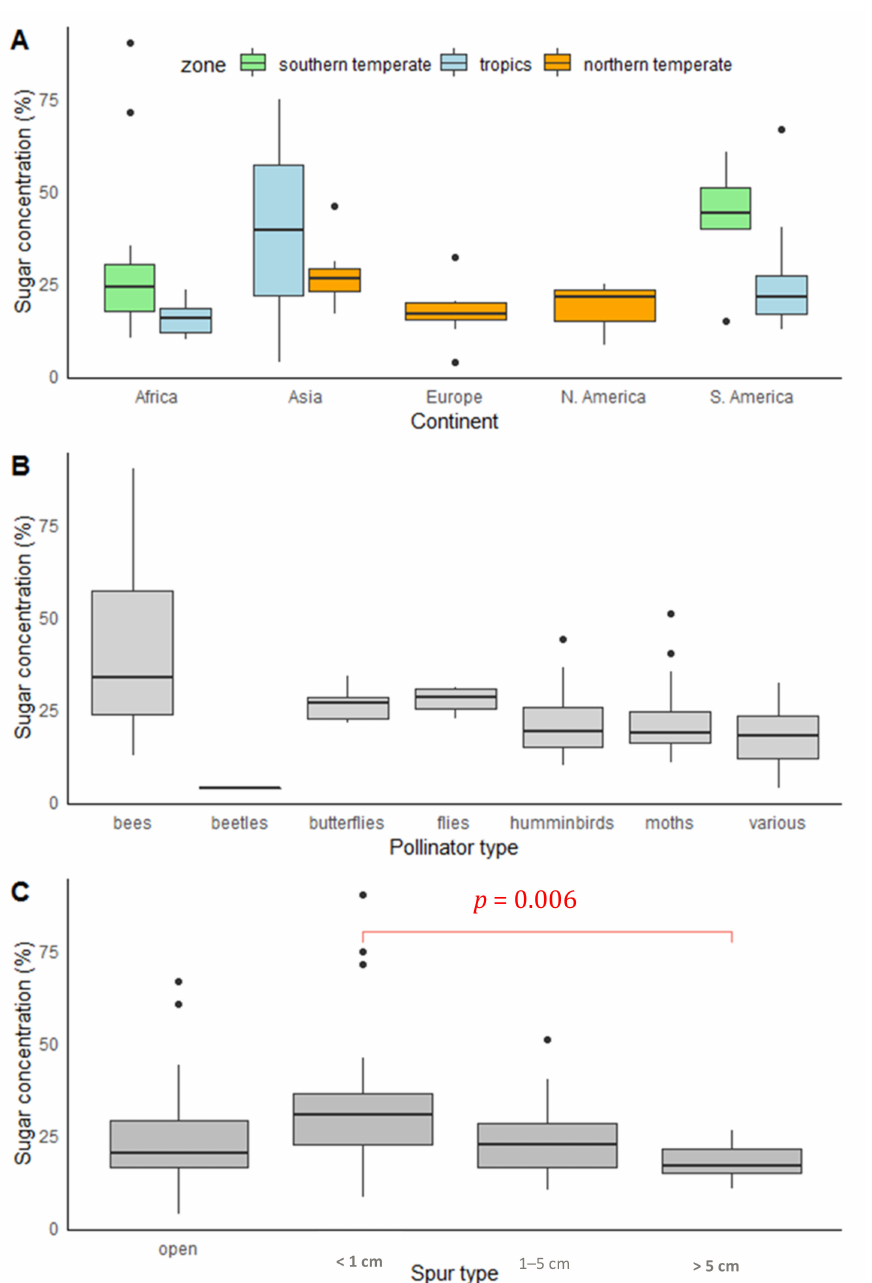
Figure 2. Sugar concentration in flowers of 106 orchid species around the globe depending on their geographical location ( A ), pollinator type ( B ), and spur type ( C ). Significant differences in Tukey’s post hoc test between spur length categories is indicated by a red line and red